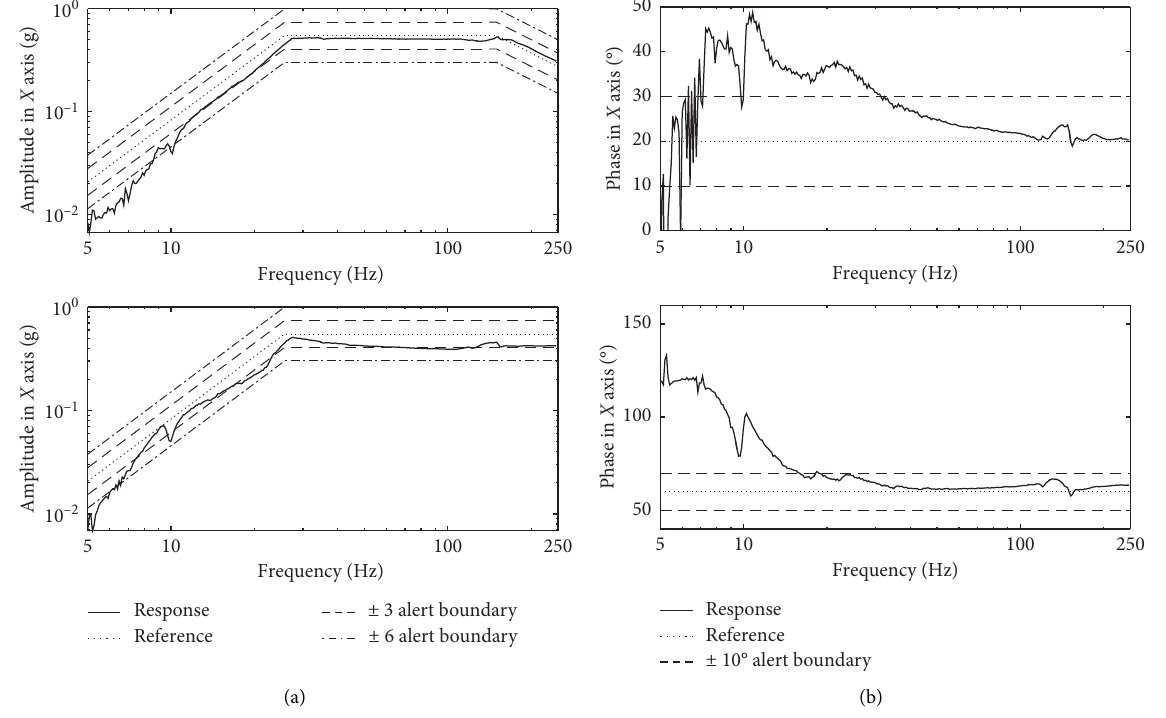
Figure 11: Responses of the lower level ( − 6dB) preliminary test without control.